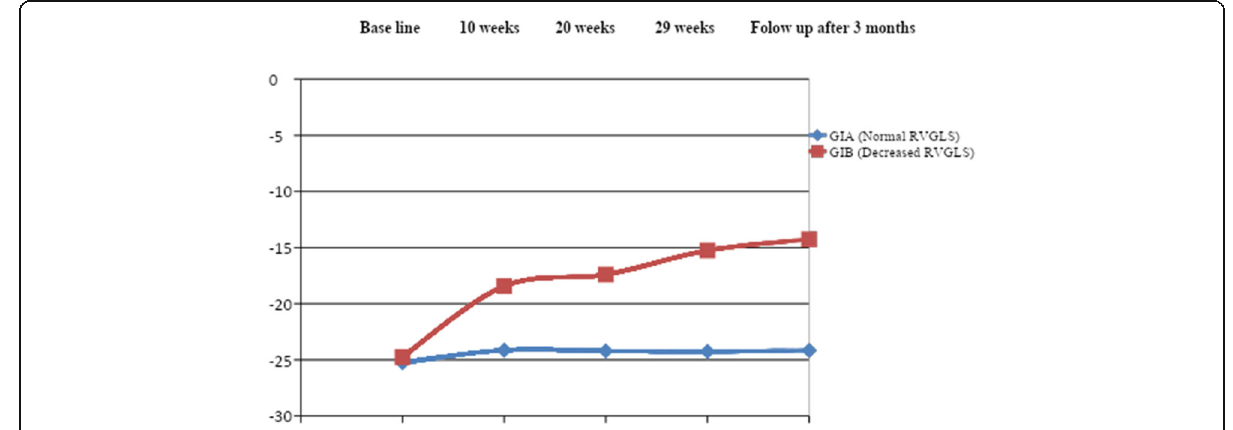
Fig. 2 Right ventricular global longitudinal strain in group 1 subgroups before, during, and after recovery of